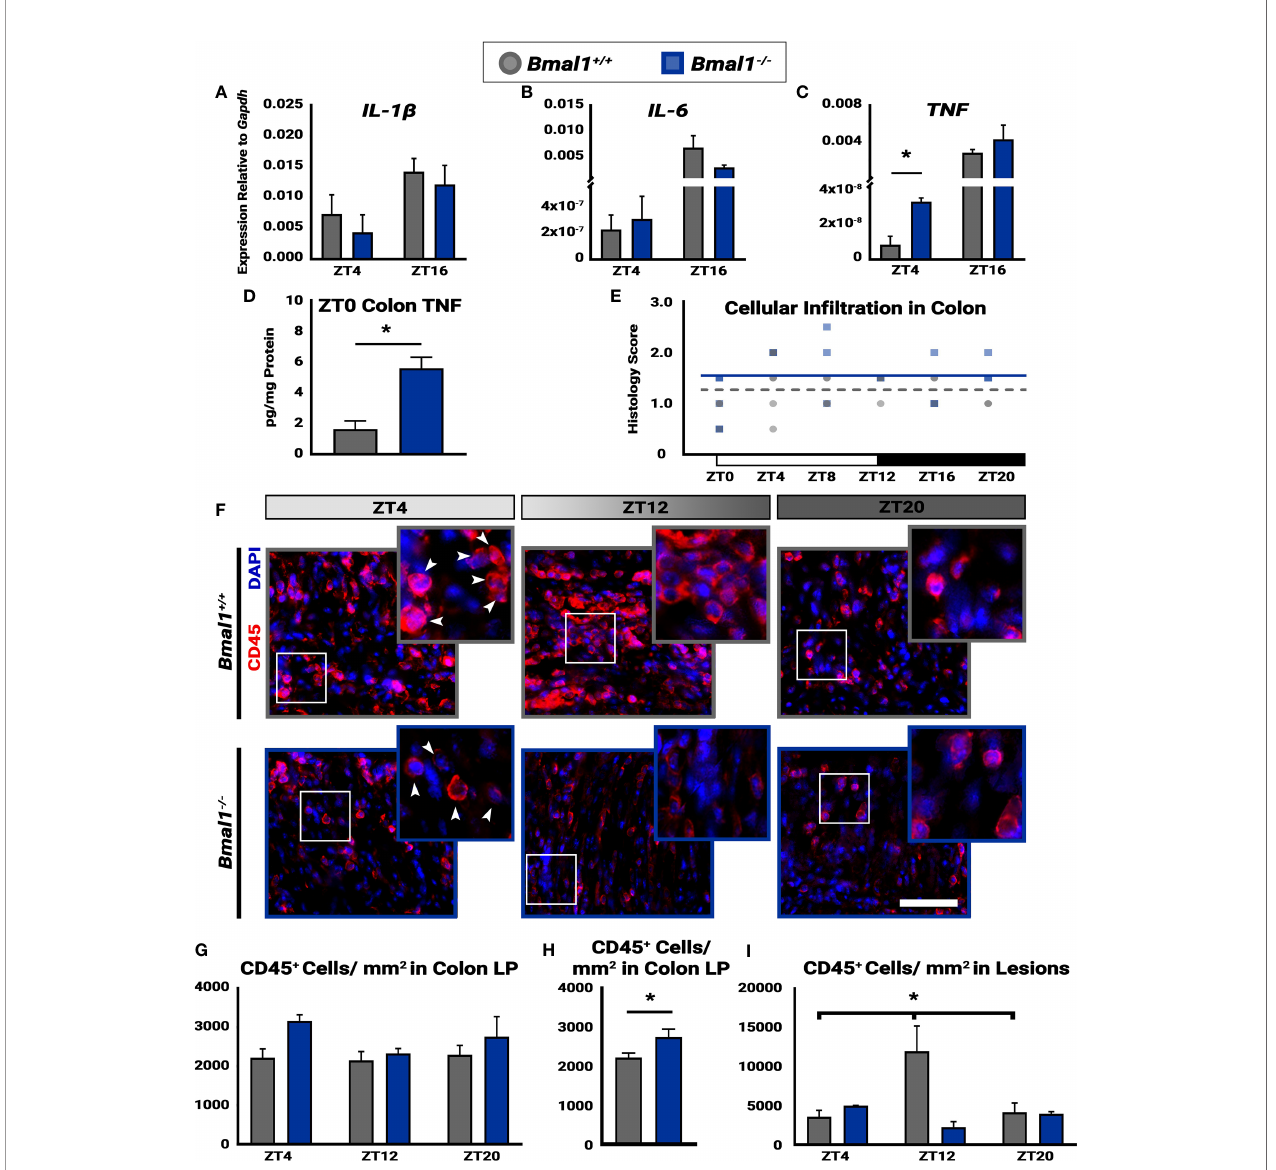
FIGURE 6 | Time-dependent cellular in fi ltration is disrupted in Bmal1 -/- mutant mice. Mice were given DSS treatment to induce colitis, and samples were collected at the indicated times. No changes in expression of (A) IL-1 b (Unpaired t -test, ZT4 p=0.5191, ZT16 p=0.4409) or (B) IL-6 between Bmal1 +/+ control and Bmal1 -/- mutant mice at ZT4 and ZT16 (Unpaired t -test, ZT4 p=0.7145, ZT16 p=0.2605). (C) Increased TNF expression is present in Bmal1 -/- colon tissue at ZT4, but no difference is present at ZT16. (Unpaired t -test, ZT4 *p=0.0100, ZT16 p=0.2719). (D) Increased TNF protein concentration in whole colon tissue lysate of Bmal1 -/- mutants is evident. (Unpaired t -test, *p=0.0115). (E) The histology scores of the whole colon indicate no variation in cellular in fi ltration across 24 hours (One-way ANOVA, Bmal1 +/+ p= 0.2388, F= 1.493; Bmal1 -/- p=0.1274, F= 2.039). (F) Images of in fi ltrating blood cells into colon lesions are marked by CD45 transmembrane protein, in red. (Arrowheads in closeup indicate examples of CD45 + cells. Scale bar = 50µm). (G) In fi ltrating blood (CD45 + ) cells in the lamina propria (LP) from normal regions of the colon exhibit no time-dependent changes in either Bmal1 +/+ or Bmal1 -/- mice. (One-way ANOVA, Bmal1 +/+ p= 0.9109, F= 0.0948; Bmal1 -/- p=0.2548, F= 1.732) (H) The average of all CD45 + cellular in fi ltration across time points (ZT4, 8, and 20) indicates an increase in Bmal1 -/- mutant mice is present (Unpaired t -test, *p=0.0360). (I) In the colon lesions, however, in fi ltrating CD45 + blood cells exhibit time-dependent changes in Bmal1 +/+ control mice, with an increase at ZT12, that is absent in the Bmal1 -/- mutant. ( Bmal1 +/+ One-way ANOVA, *p= 0.0474, F=5.287; Tukey ’ s test, Bmal1 +/+ - Bmal1 -/- ZT12, *p=0.0056). (Gene expression normalized to Gapdh . All error bars represent